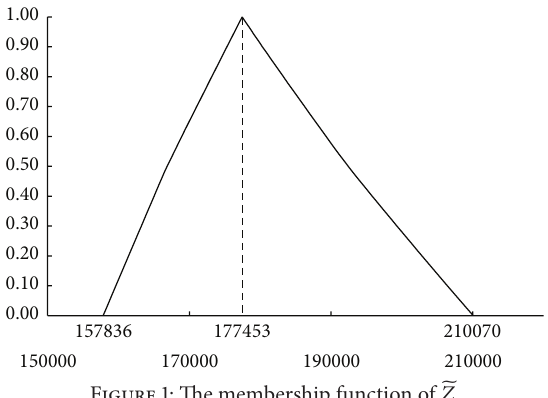
Figure 1: The membership function of